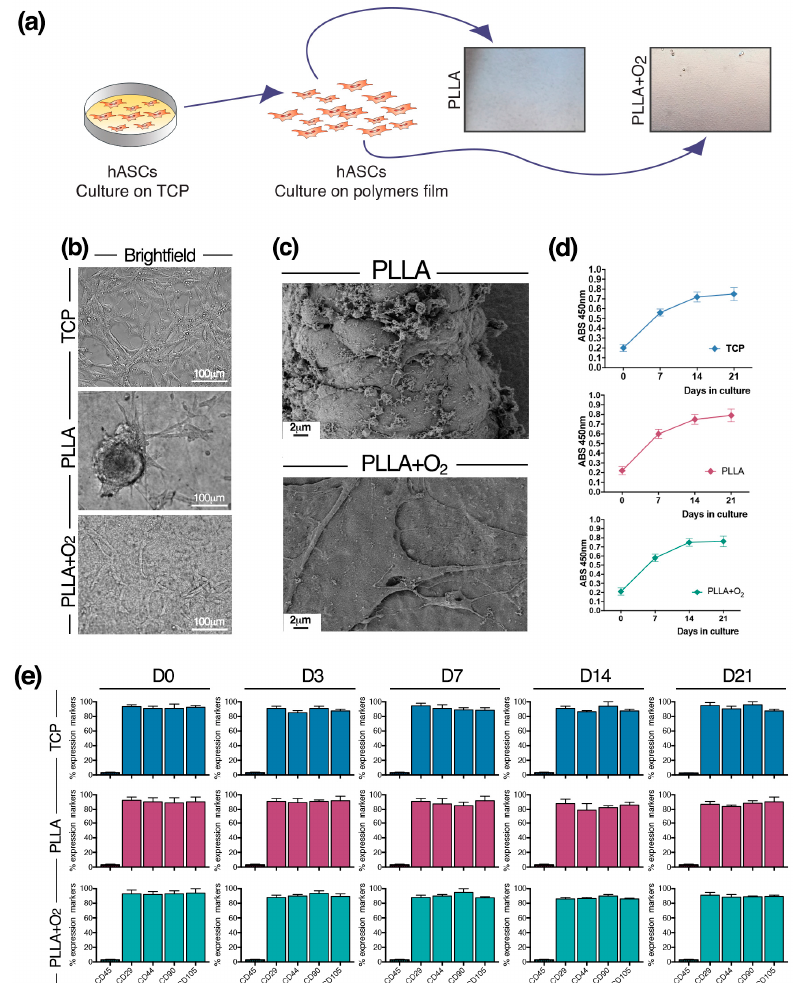
Figure 2. hASCs cultured on PLLA and PLLA+O 2 polymer films. ( a ) Schematic of hASCs on PLLA and PLLA+O 2 culture platforms; ( b ) brightfield representative images of hASCs on TCP, PLLA, and PLLA+O 2 ; ( c ) FESEM representative images highlight the hASCs spheroids organization on PLLA film and the monolayer fibroblast-like shape on PLLA+O 2 film; ( d ) hASCs viability (XTT assay) on TCP, on PLLA, and on PLLA+O 2 ; and ( e ) expression of mesenchymal stem cell markers in hASCs at different time points of culture (0, 3, 7, 14, 21) on TCP, on PLLA, and on PLLA+O 2 . Average values for mesenchymal phenotype markers shown by hASC ( n = 3) are reported as the mean ±